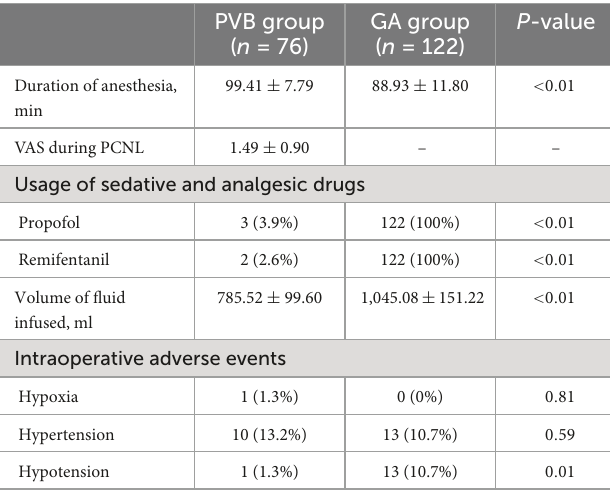
TABLE 3 Anesthesia parameters of the